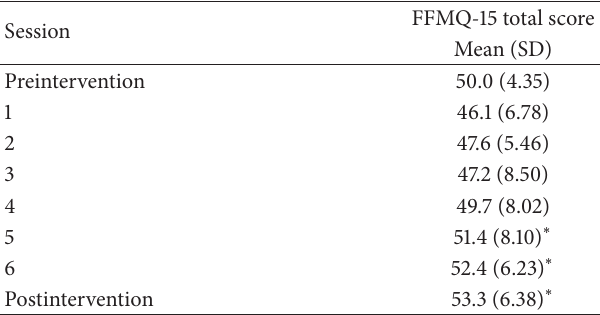
Table 2: Weekly change in overall mindfulness